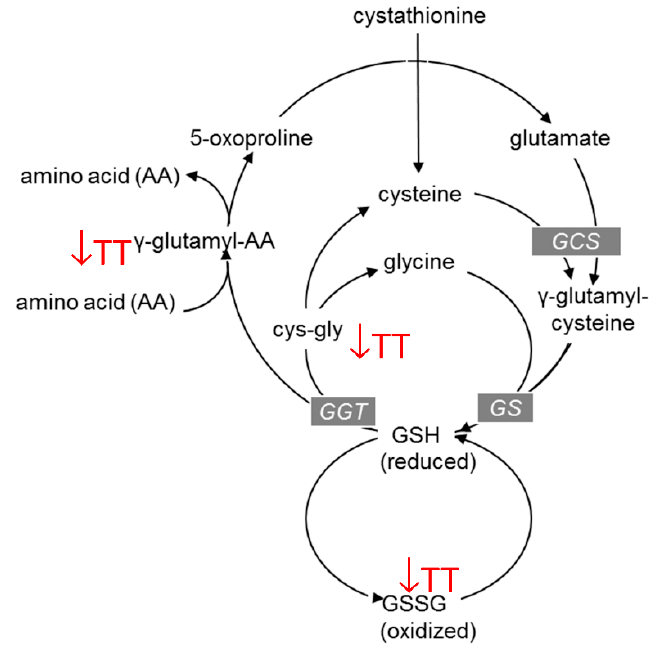
Figure 5. Effects of TT supplementation on the methionine-cysteine cycle and GSH/GSSH redox status. Supplementation of mice fed a HFD with TT alters the amounts of intermediates in amino acid metabolism and oxidized glutathione that reflect a lowered ratio of reduced glutathione/oxidized glutathione (GSH/GSSH), and thus, a lowered oxidative stress. TT, tocotrienol.